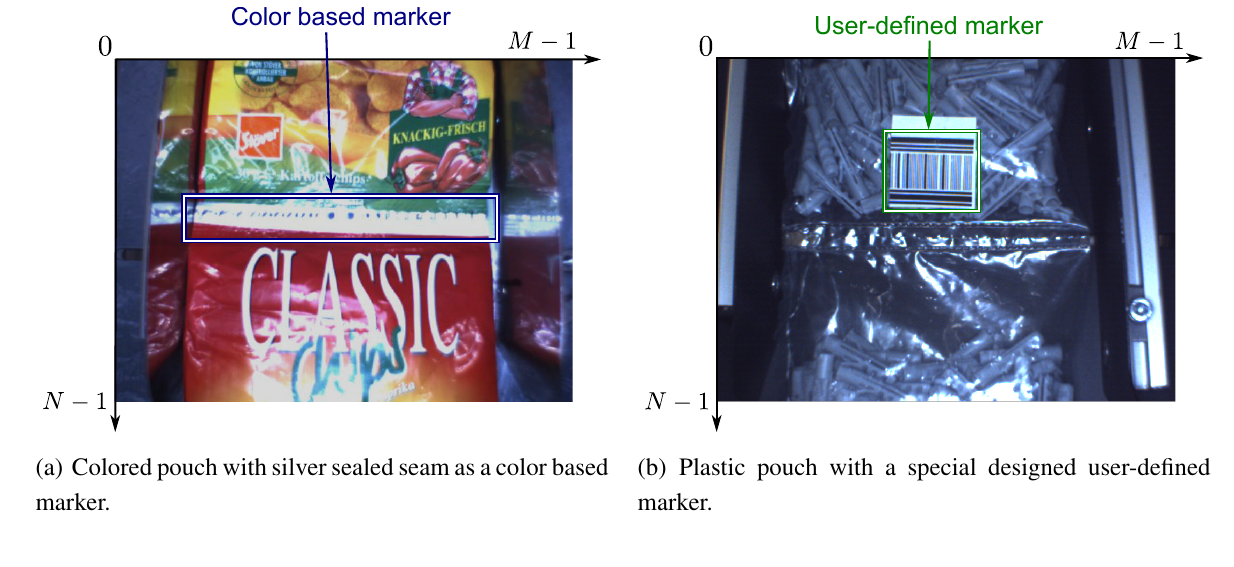
Figure 6. Two different types of marker: ( a ) a silver sealed seam as a color based marker and ( b ) a plastic pouch with a specially designed user-defined marker.